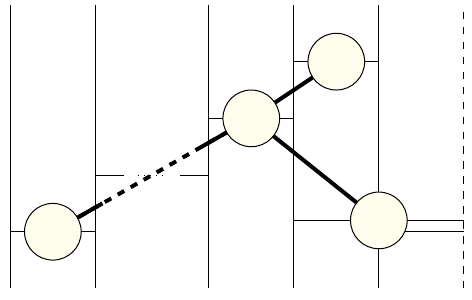
Figure 11 . D -type quiver diagram in representation